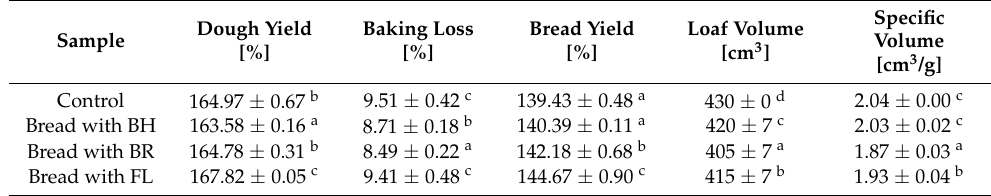
Table 6. Parameters of the laboratory baking of the rye–wheat breads with fiber